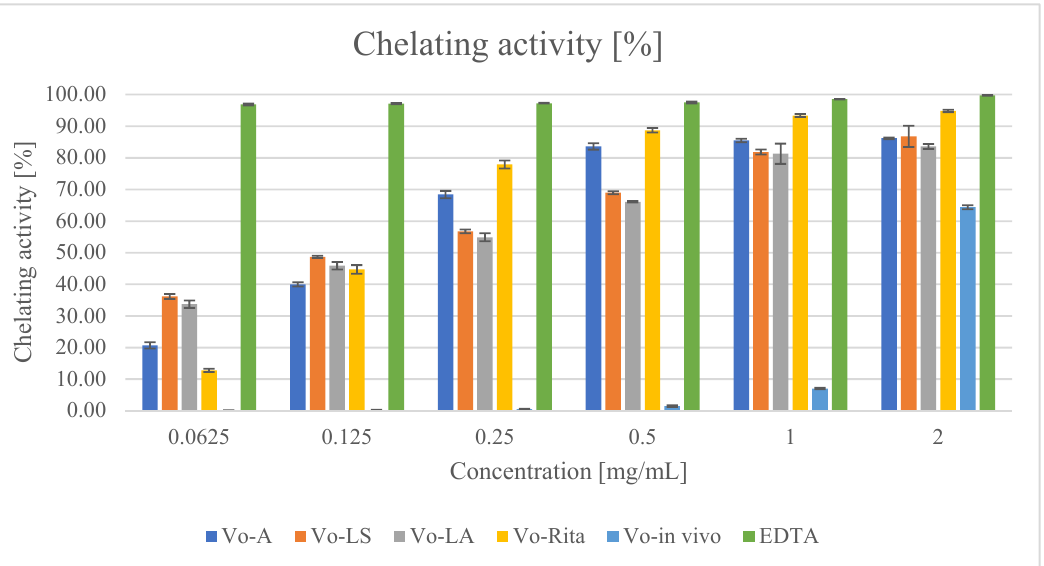
Figure 5. Ferrous ion (Fe 2+ ) chelating activity of extracts of V. officinalis in vitro cultures; agar (Vo-A), stationary liquid (Vo-LS), agitated (Vo-LA) and bioreactor cultures (Vo-RITA) and of plant material (Vo-in vivo). Values are expressed as mean ± SD (n =